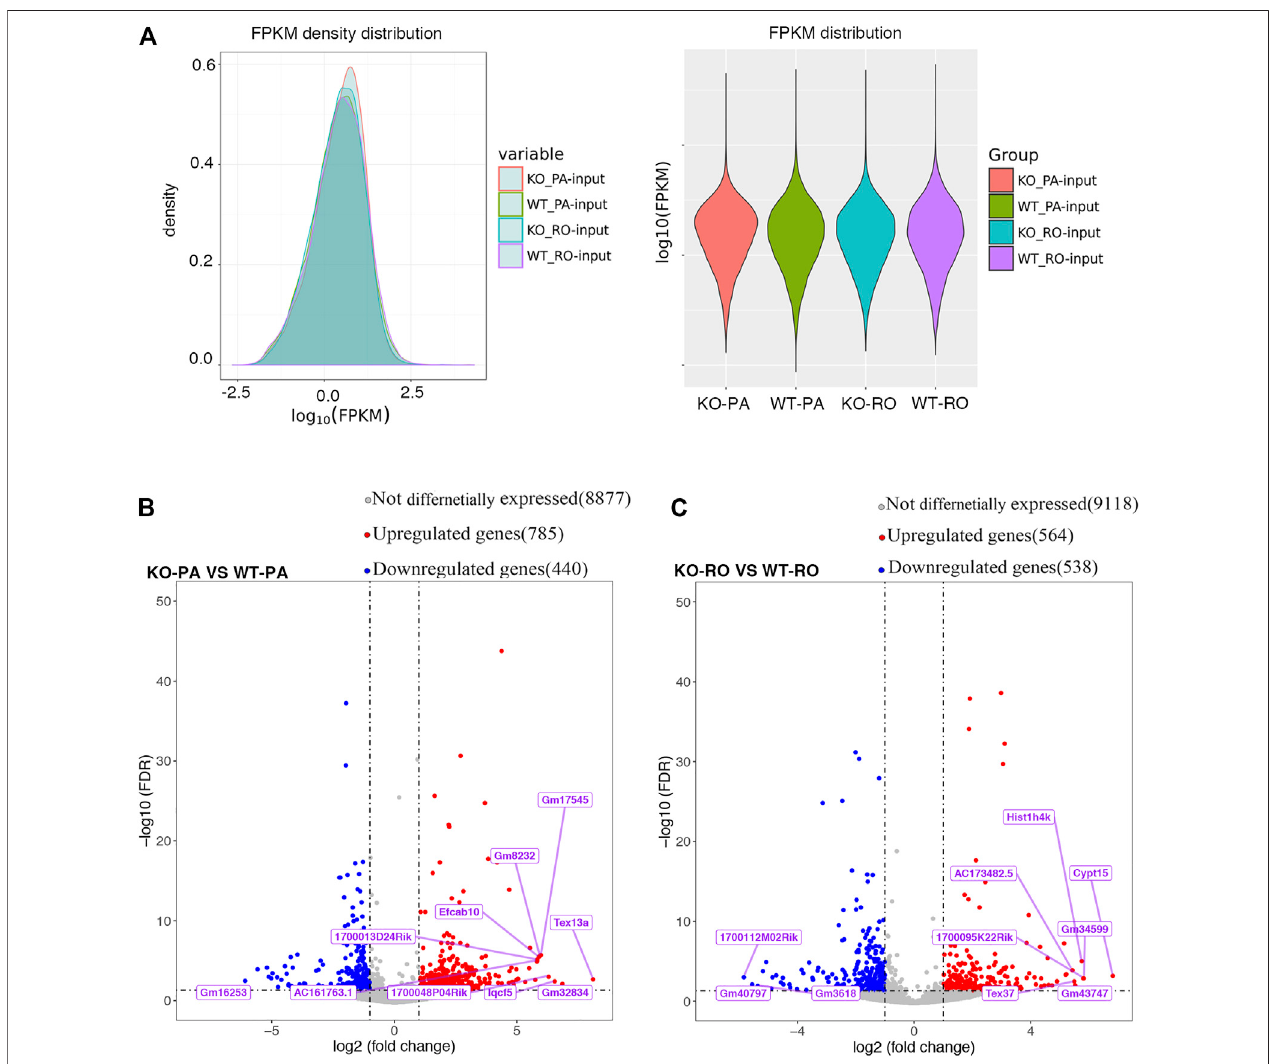
FIGURE4| DifferentialgeneanalysisFPKMdensitydistribution (A) .Volcanoplotshowingdifferentialgenesbetween Alkbh5 -KOPAandWTPA (B) , Alkbh5 -KORO and WT RO (C) .